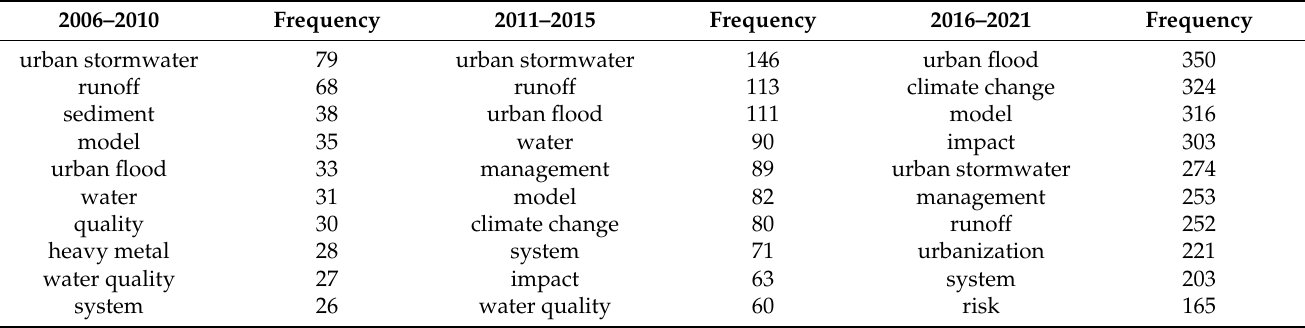
Table 4. Comparison of the top 10 keywords in the three